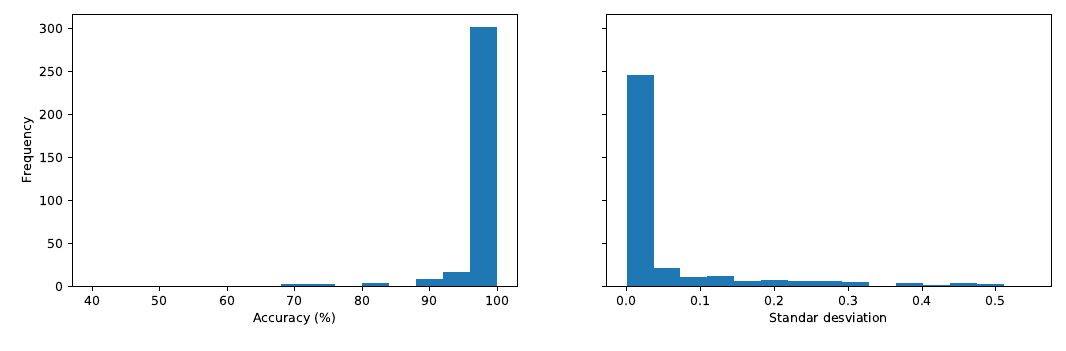
Figure 3. Classification results by class.